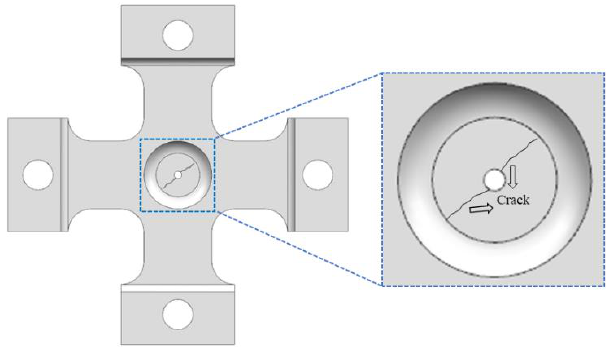
Figure 5. Criterion of crack condition at termination of biaxial fatigue test.